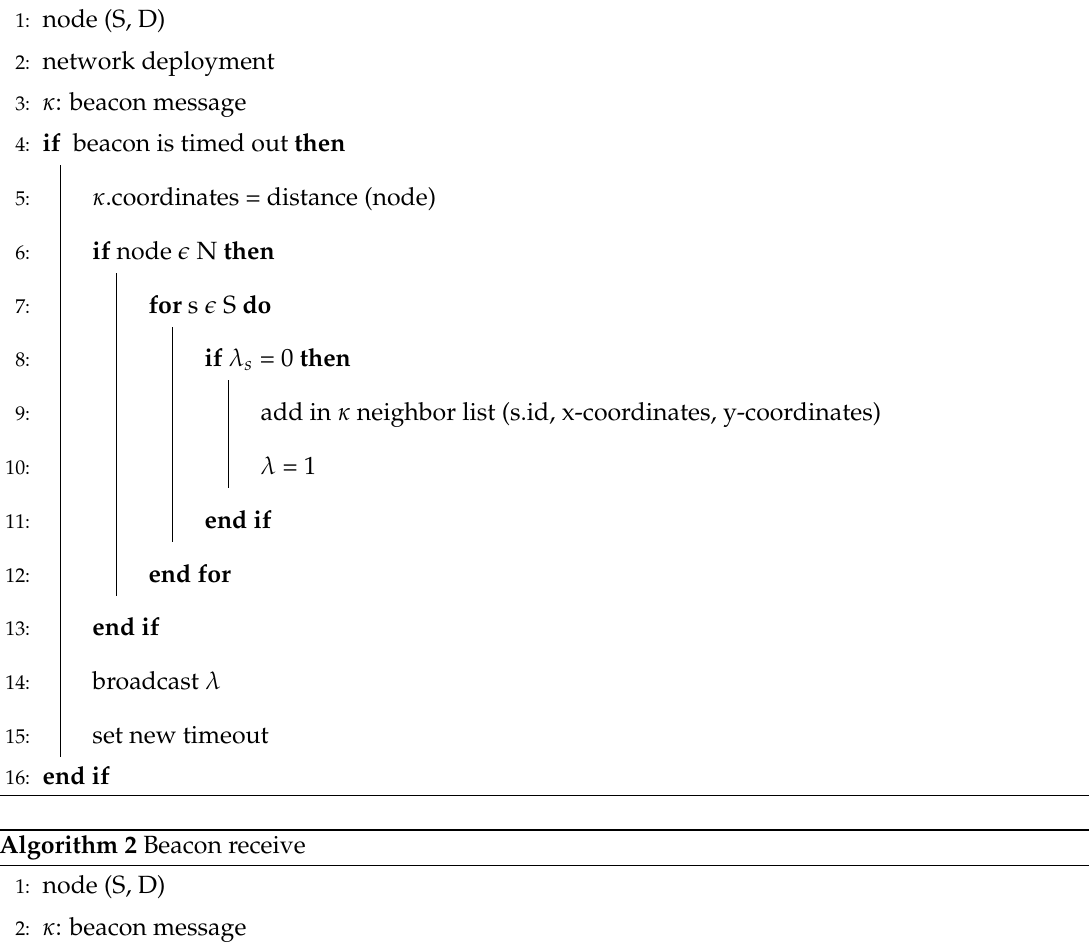
Algorithm 1 Periodic